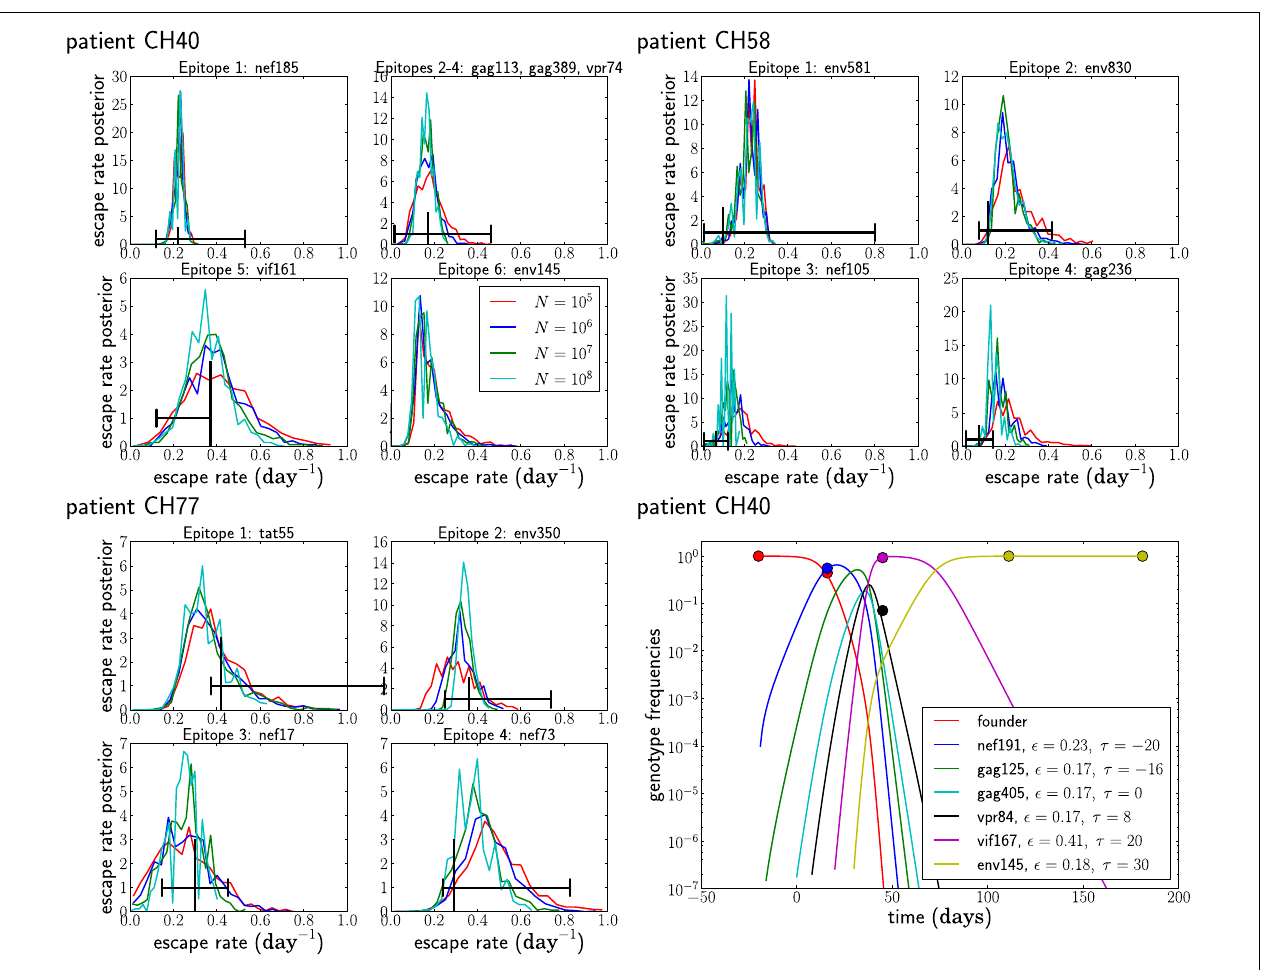
FIGURE 9 | Posterior distributions of escape rate assuming a mutation rate µ = 10 − 4 per day . See Figure 8 for other details.